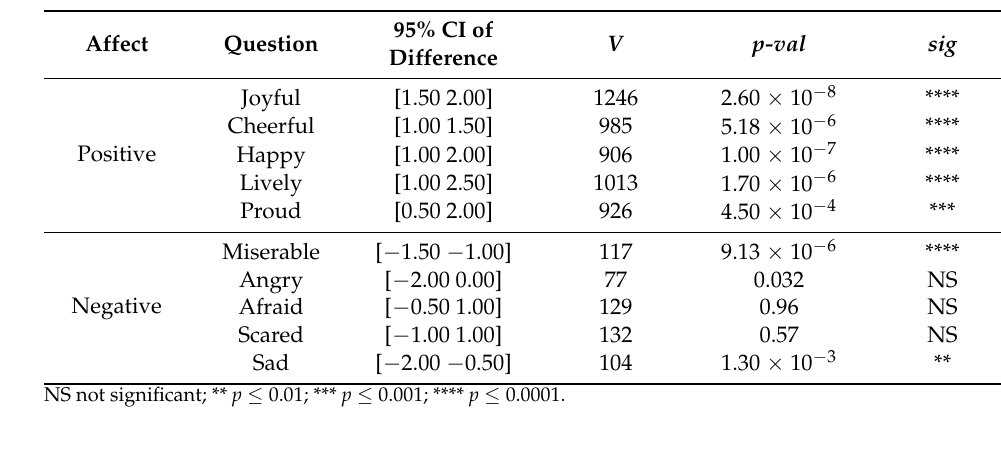
Table 3. Positive and negative affect components tested between pre and post survey timing.